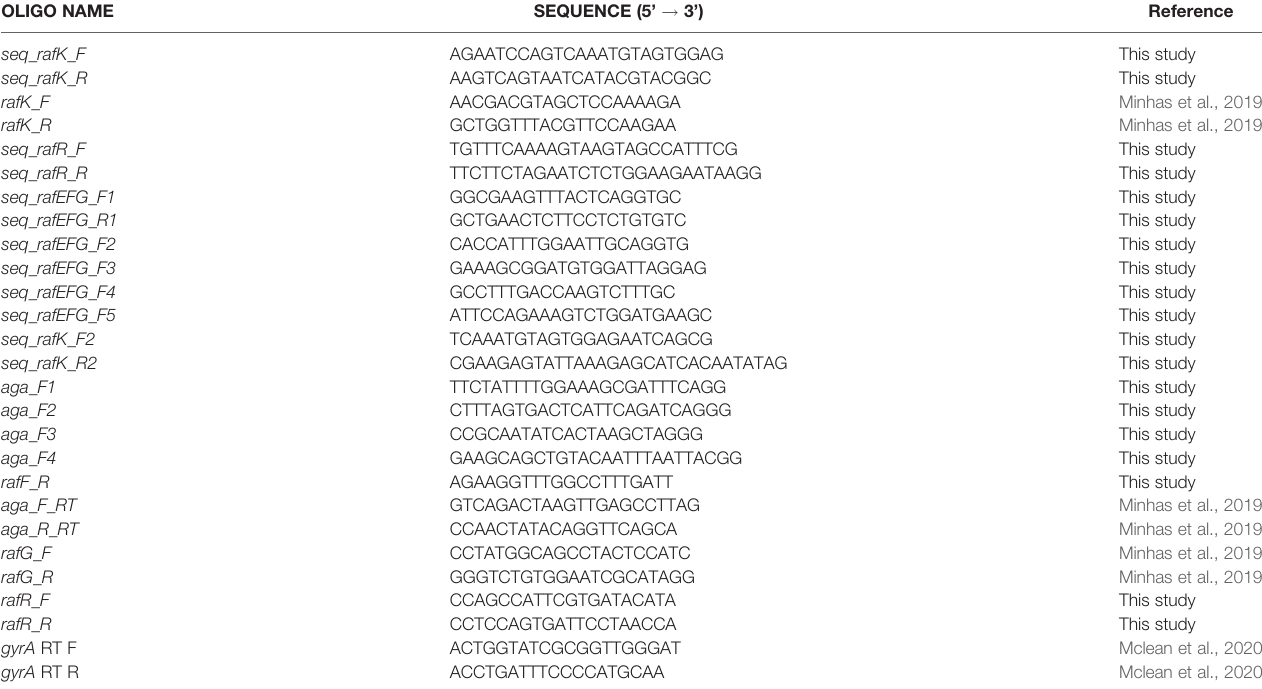
TABLE 2 | Oligonucleotide primers used in this study for